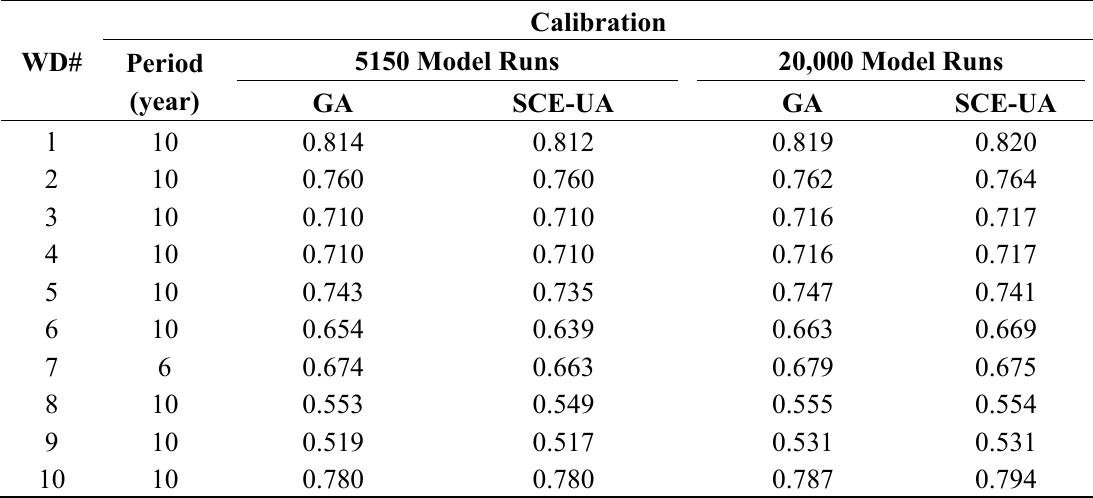
Table 5. Automatic calibration performance of L-THIA based on monthly